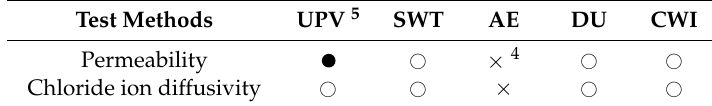
Table 2. Evaluation of regain in durability properties due to self-healing. Test